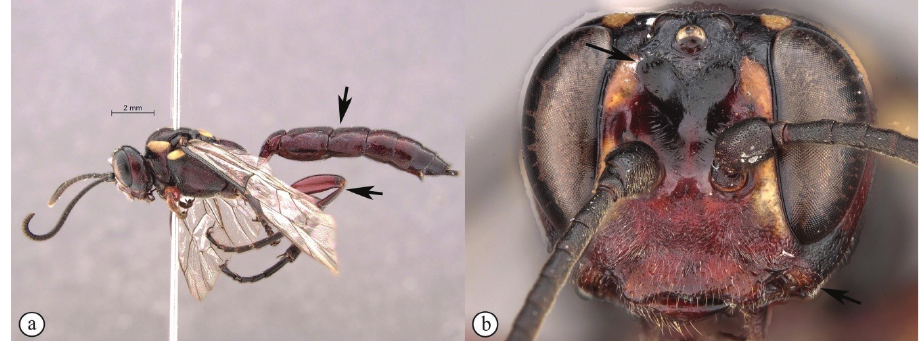
– Metasoma, hind femora and tibiae reddish (a); frons with an acute cordate lamella above the antennal scrobes (b) .......................................................... .............................. G. phagocossorum Rousse, Broad & van Noort, sp. n.